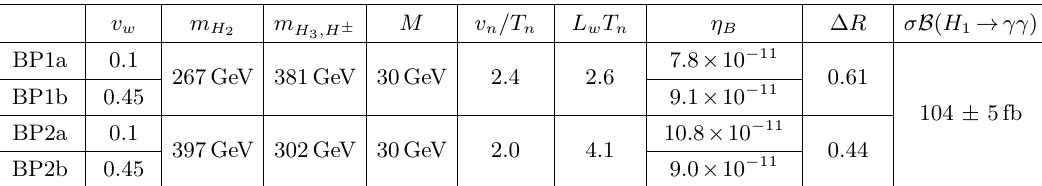
Table 3 . The input parameters of the four benchmark points v w , m H shown. In addition, v shown in eq. (1.1) can be explained in both BP1b and BP2b. As phenomenological